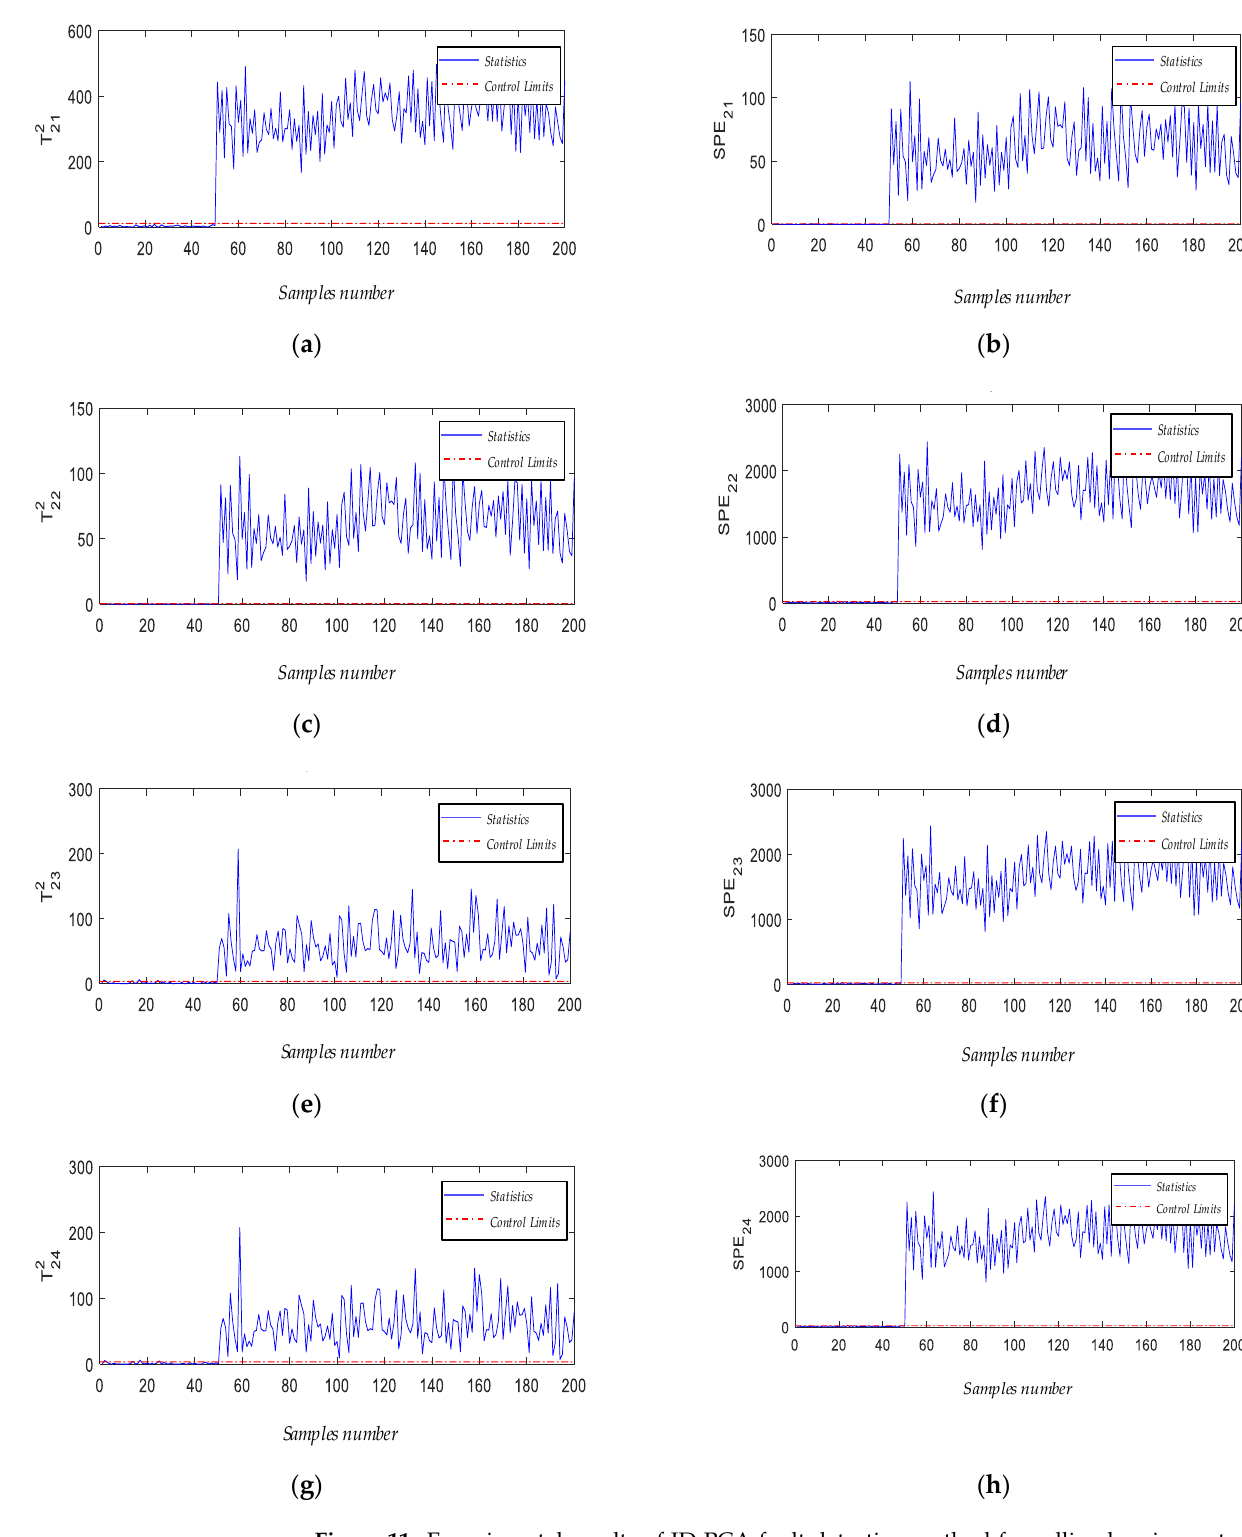
Figure 11. Experimental results of ID-PCA fault detection method for rolling bearing outer ring: ( a ) the result of T 2 ; ( b )the result of SPE 21 ; ( c ) the result of T 2 ; ( d ) the result of SPE 22 ; ( e ) the result of 22 21 T 2 ; ( h ) the result of SPE 24 ; ( f ) the result of SPE 23 ; ( g ) the result of T 2 result of 23 24